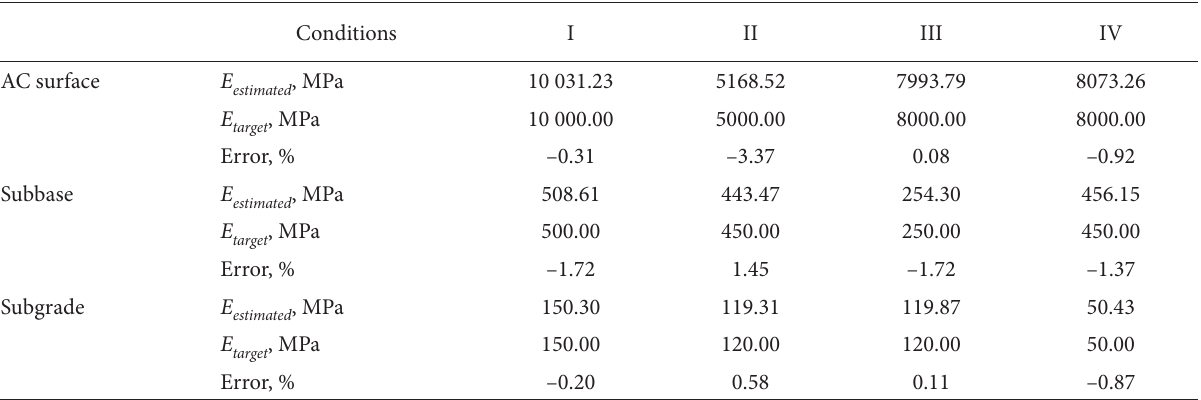
Table 4. Estimation results by NN without modeling error for bedrock boundary case